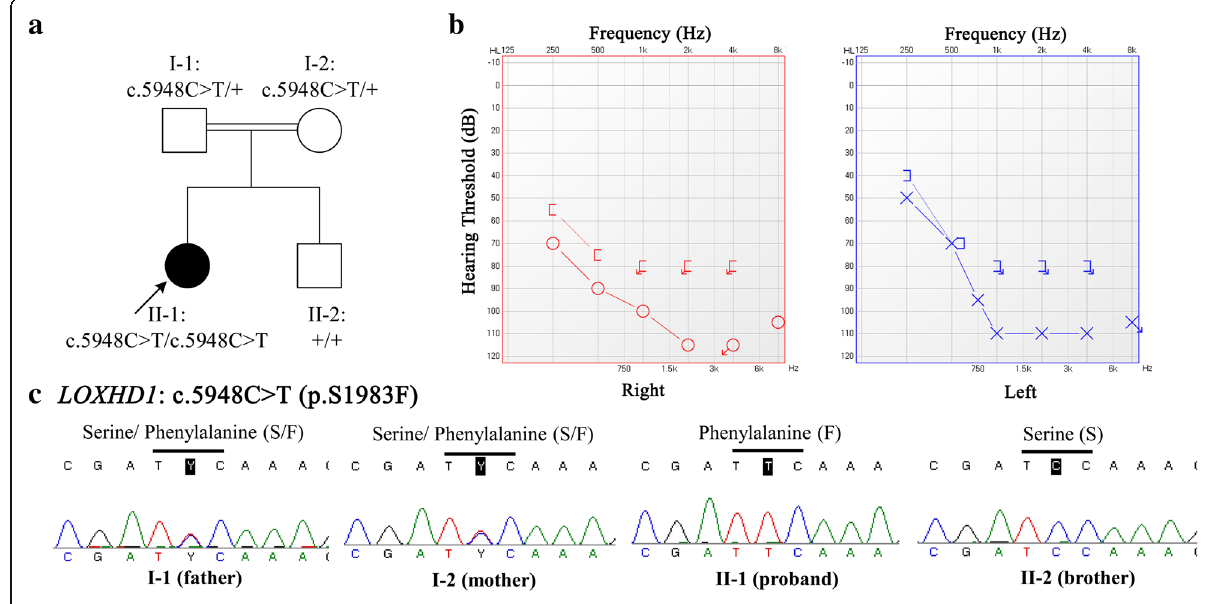
Fig. 1 Pedigree, audiological evaluation and Sanger sequencing validation. a . Pedigree of this Chinese family under consanguineous marriage. The proband was indicated by arrows. “ + ” indicates wild type. b . Pure-tone audiometry evaluation of this proband. c . LOXHD1 : c.5948C>T variants were validated by Sanger